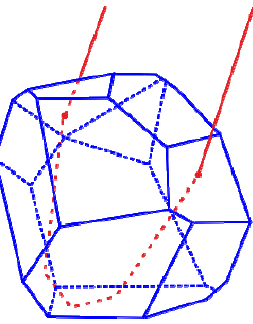
Figure 5. Visualization of non-specular trajectory presented in Fig.